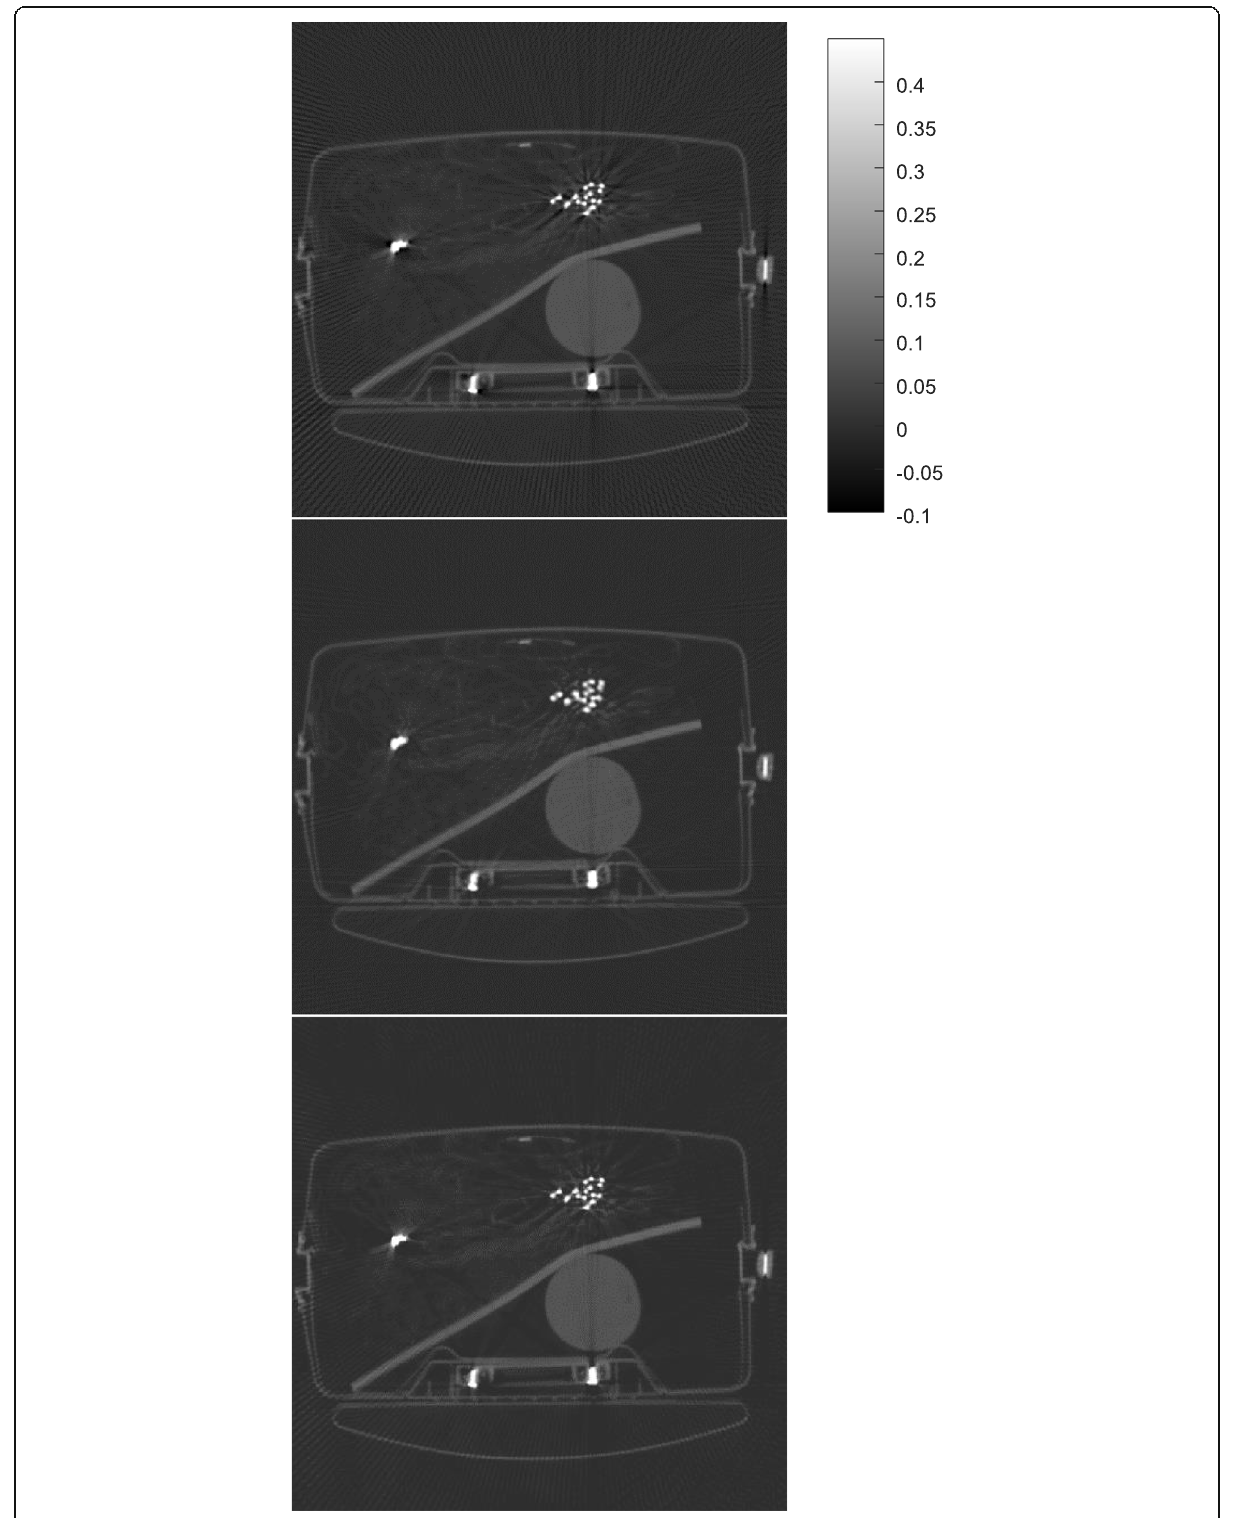
Fig. 1 CT image reconstruction of airport bag #1. Top: the raw FBP reconstruction; Middle: the reconstruction using the proposed algorithm; Bottom: the raw FBP reconstruction with all negative pixel values replaced by